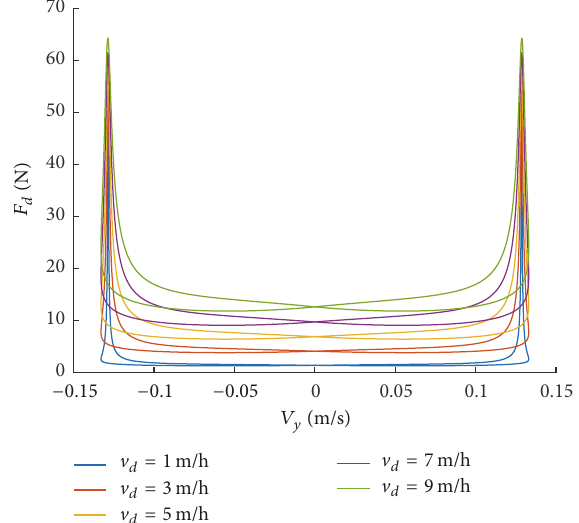
Figure 16: Loop of the axial force of the drill string and relative motion velocity.